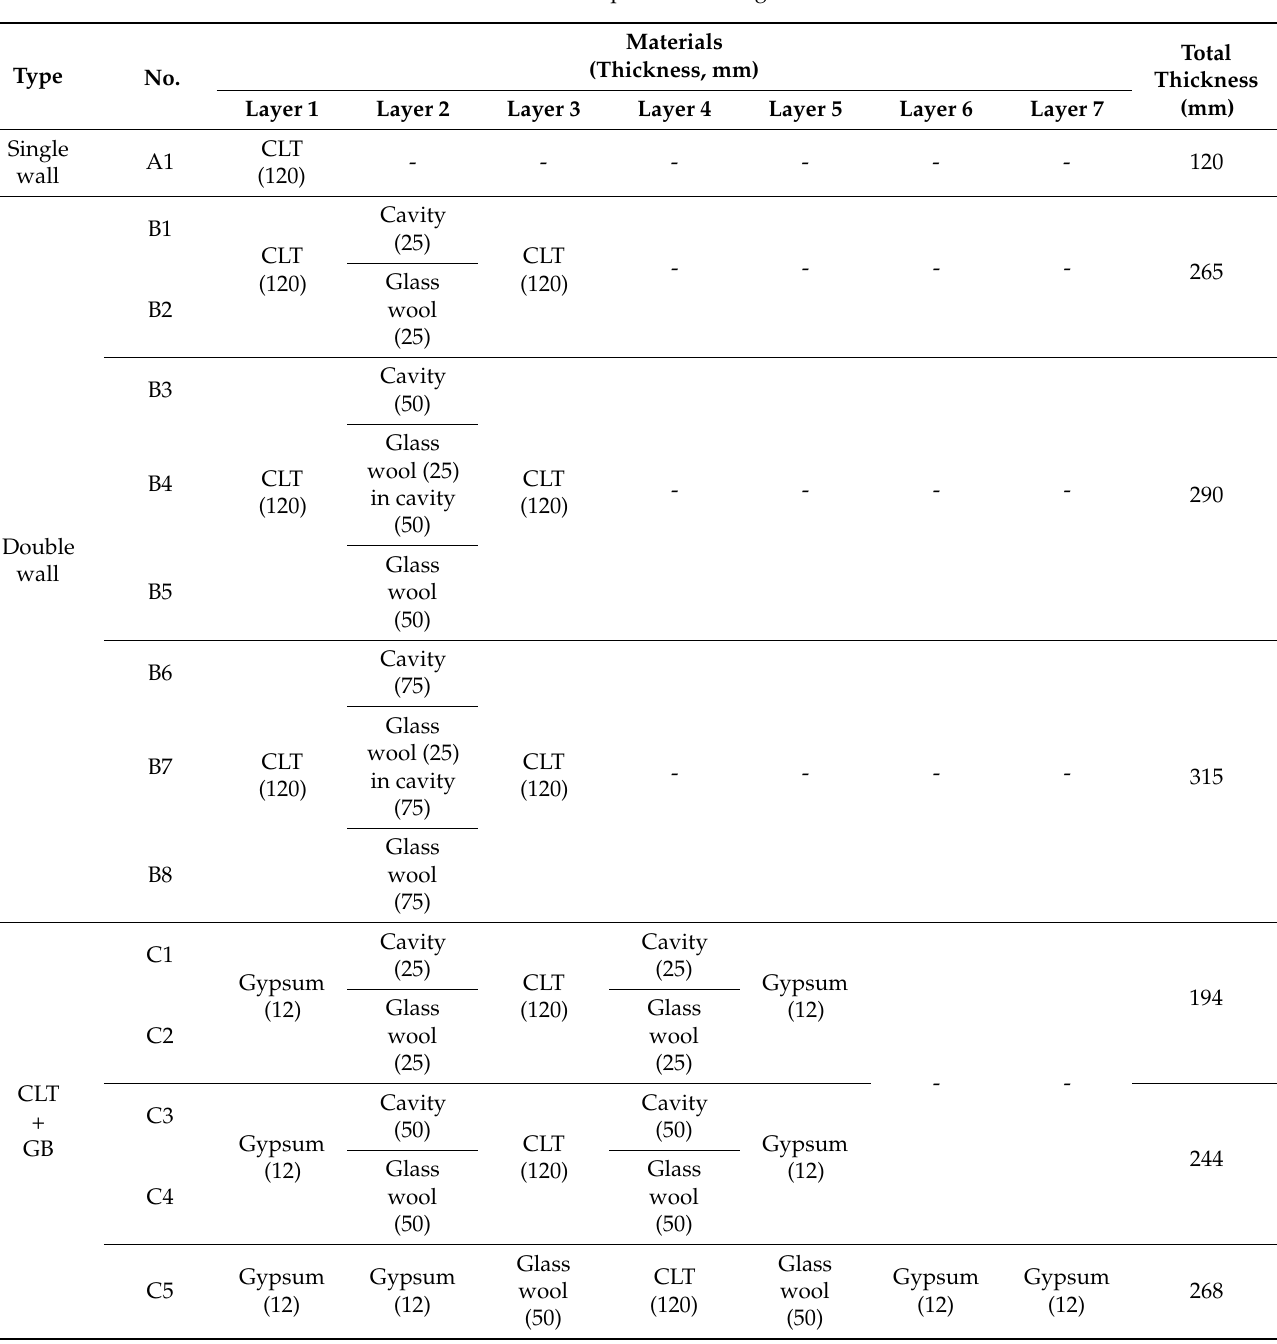
Table 2. Test specimen